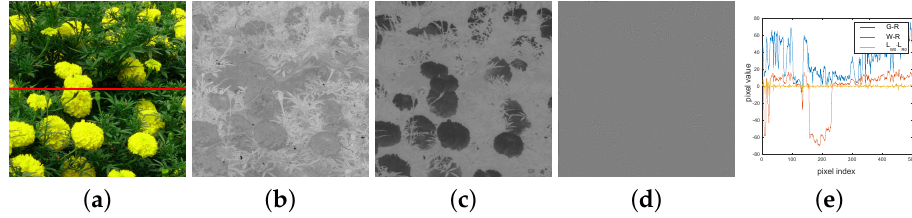
− L R 0 , ( e ) pixel values of the 0